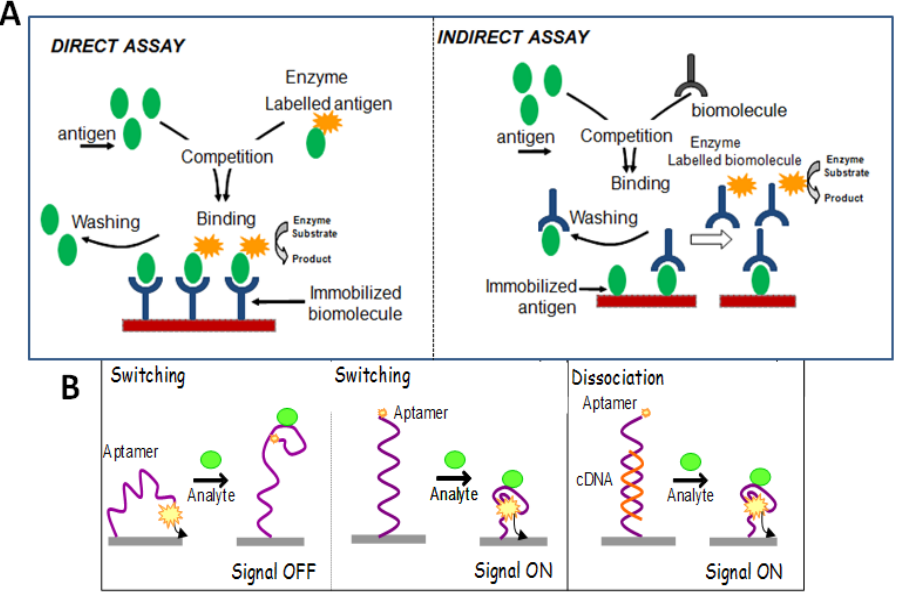
Figure 3. ( A ) Direct and Indirect competitive formats in the affinity based biosensors; ( B ) Additional formats in case of aptamer based assays.